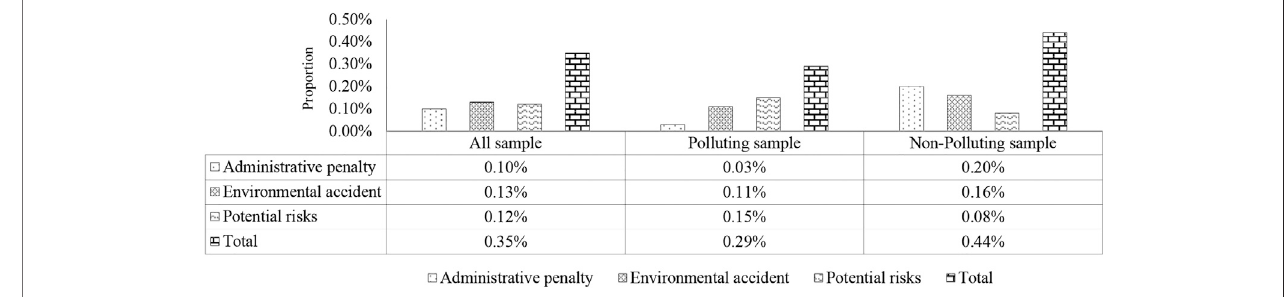
FIGURE 1 | Asymmetry of environmental information